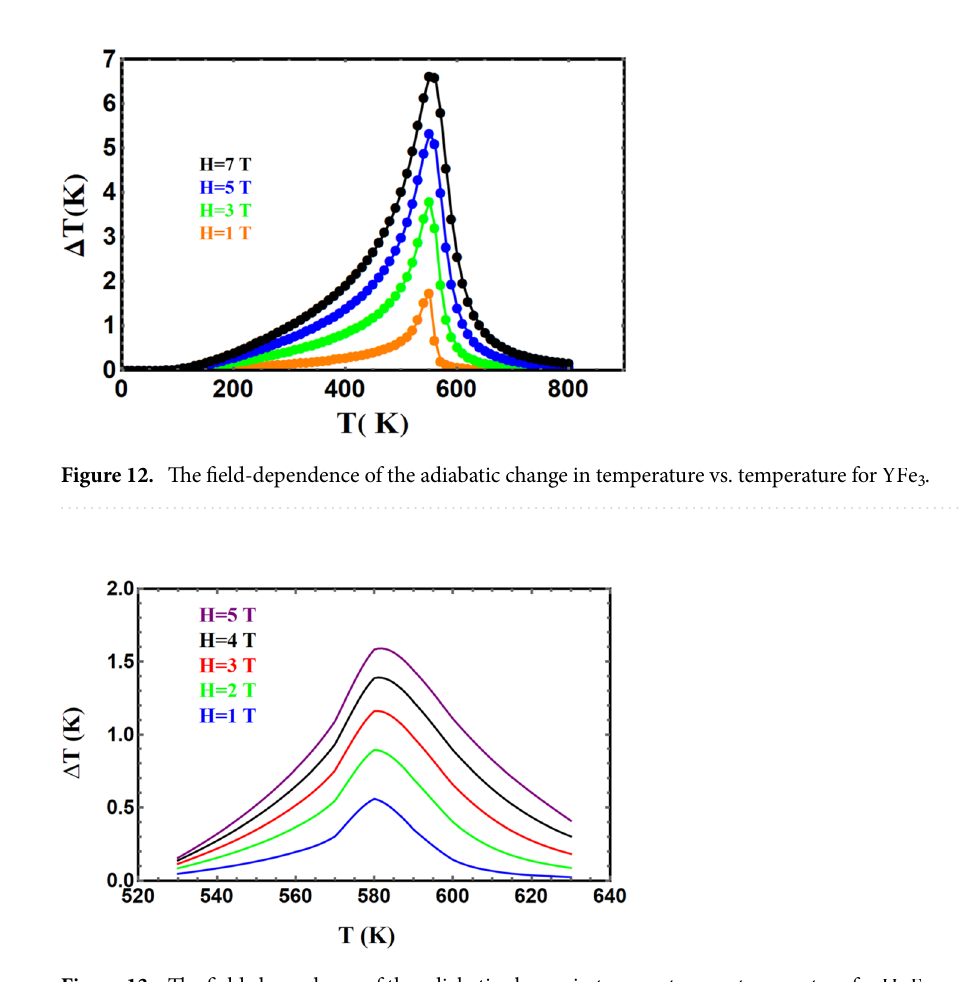
Figure 13. The field-dependence of the adiabatic change in temperature vs. temperature for HoFe 3